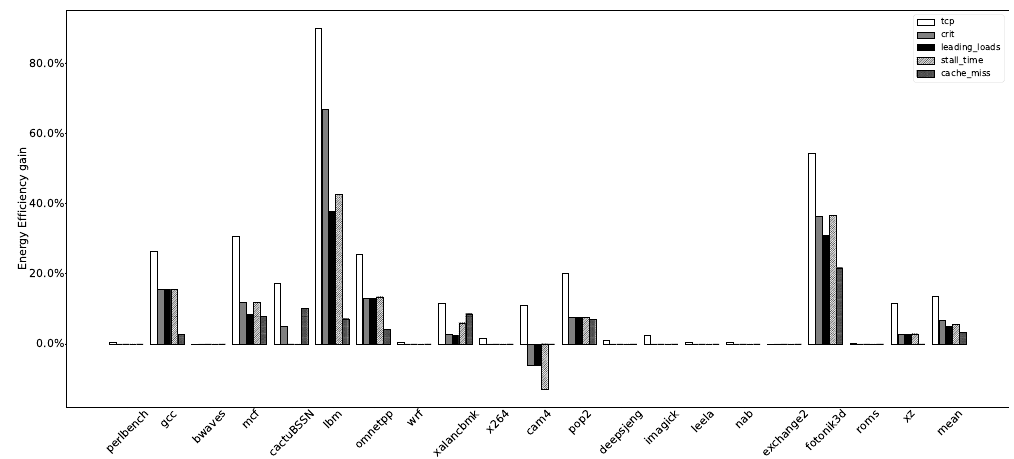
Figure 9. Comparison of the energy efficiency of power management methods.